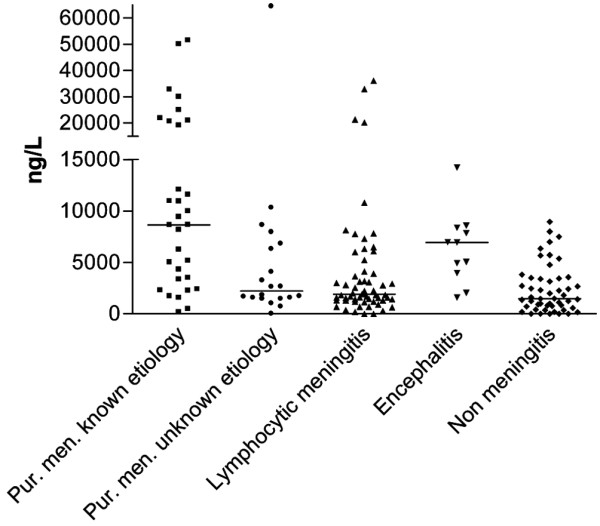
CSF MIF levels from patients with suspected or confirmed meningitis at admission. There was a significant difference between the five diagnostic groups (Kruskal Wallis: P < 0.0001). Bars indicate medians. Group 1 includes patients with purulent meningitis of known aetiology (n = 31), group 2 purulent meningitis of unknown aetiology (n = 20), group 3 lymphocytic meningitis (n = 59), group 4 encephalitis (n = 11) and group 5 no CNS infection (n = 50). P values calculated using the Mann Whitney test. Group 1 versus group 2 (P = 0.003) versus group 3 (P < 0.001) versus group 4 (P = 0.2) versus group 5 (P < 0.001). Group 2 versus group 3 (P = 0.5) versus group 4 (P = 0.04) versus group 5 (P = 0.055). Group 3 versus group 4 (P = 0.004) versus group 5 (P = 0.075). Group 4 versus group 5 (P < 0.001). CSF, cerebrospinal fluid; MIF, macrophage migration inhibitory factor.